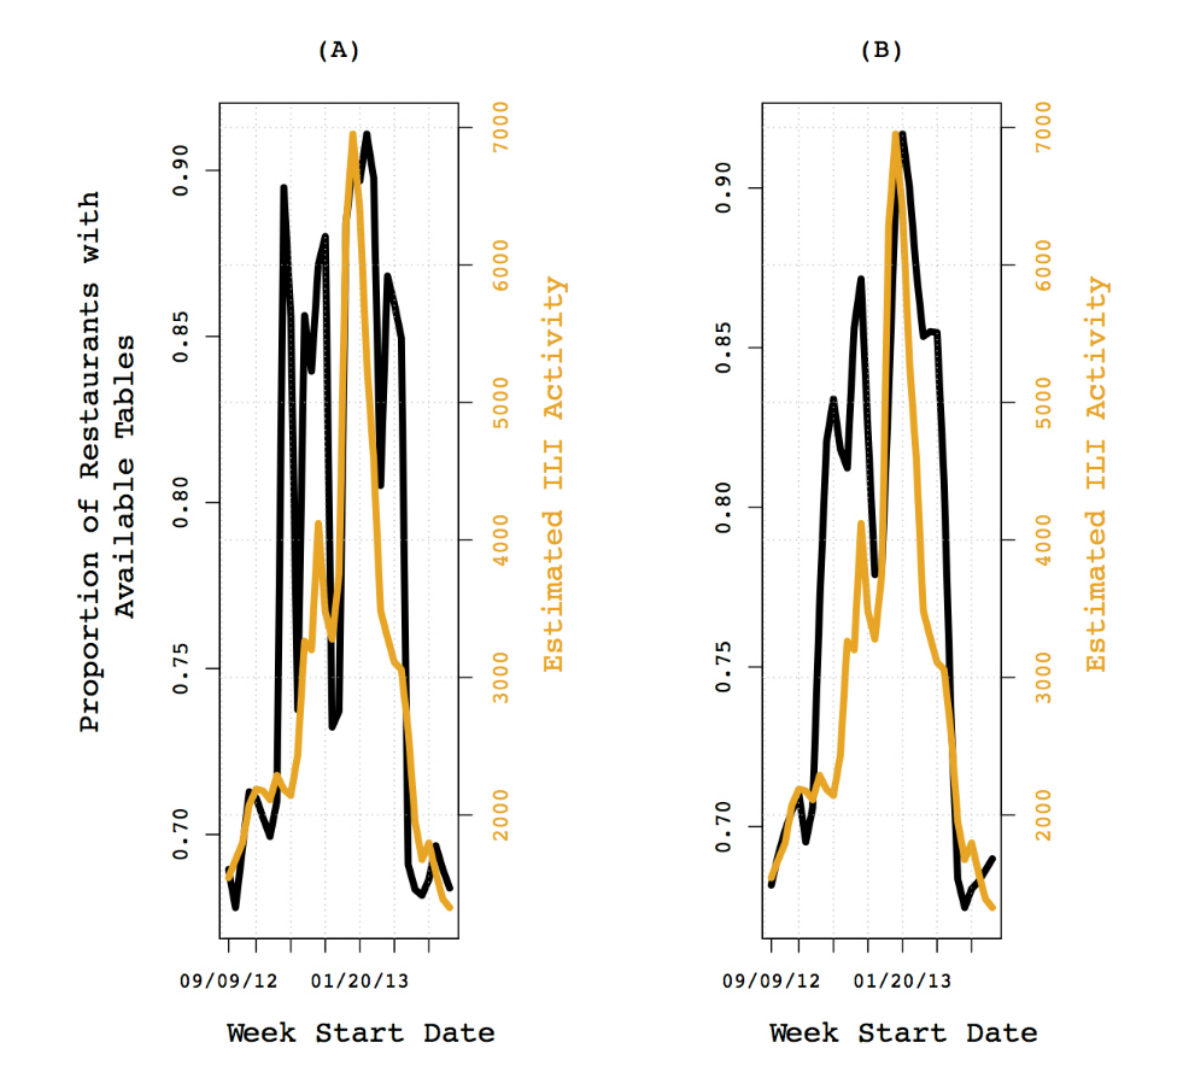
Figure 1. The trend in the proportion of restaurants with table availability at 10:00 PM for Miami compared to Google Flu Trend data for Miami. (A) Restaurant table availability and Google Flu Trend curve; (B) curve with LOESS smoothing to capture the overall trend in